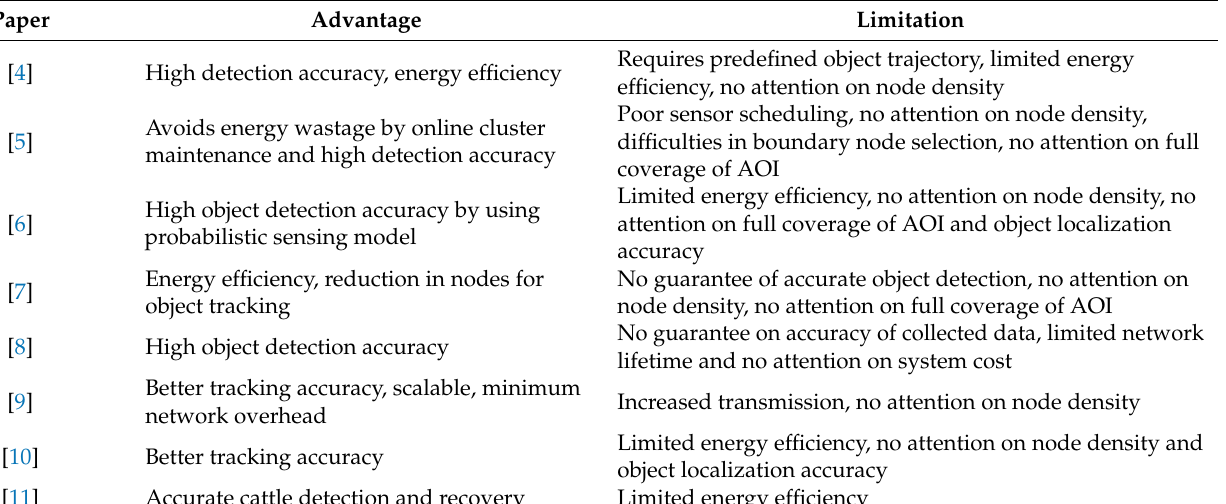
Table 3. Comparative Study of Past Research-II. Paper